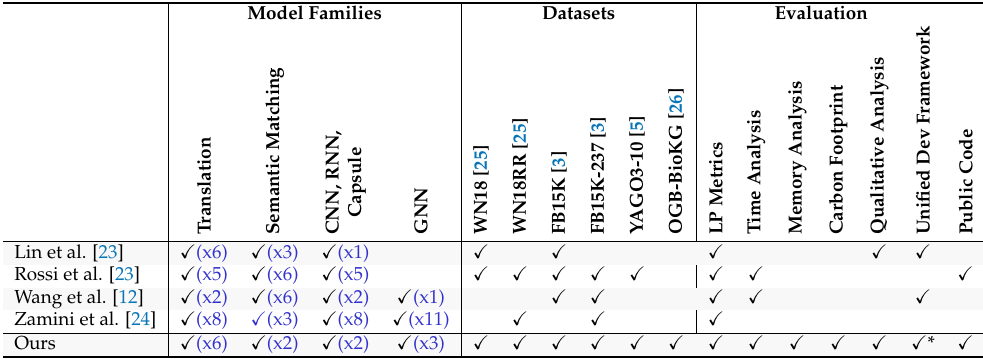
Table 1. Model families, datasets, and evaluation criteria explored by the surveys most relevant to our work. Blue values in brackets indicate the number of methods for each family. * = except for results taken from previous